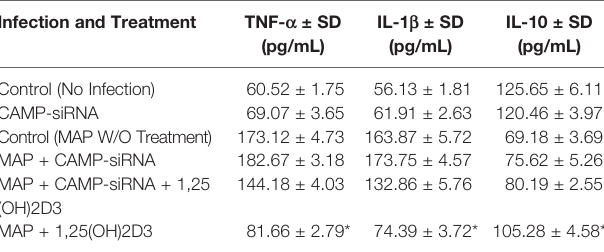
*Indicates P-value of less than